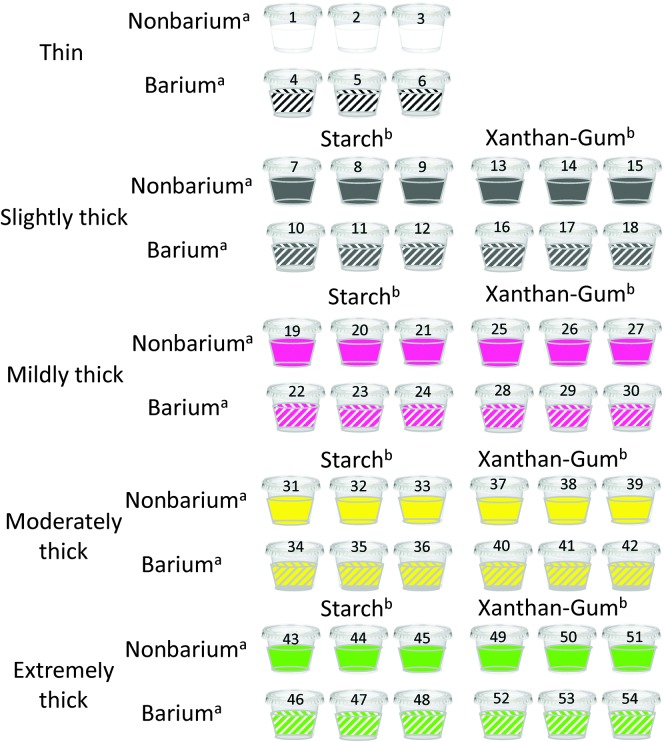
Study protocol. Nonbarium stimuli are indicated in solid colors. Barium stimuli are indicated in hashed colors. Numbers indicate the order of presentation. aRandomization factor by presence of barium in stimuli. bRandomization factor by thickener type.